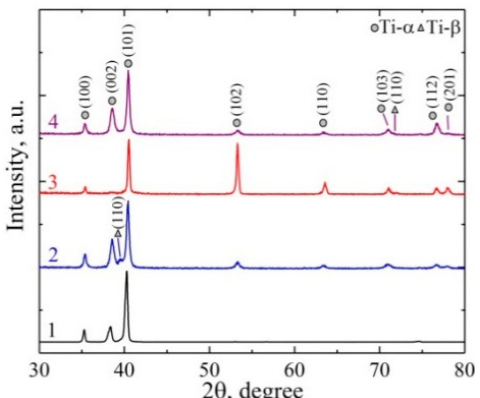
Figure 11. X-ray diffraction patterns of as-built (1—outermost surface layer, 2—core region) and Figure 11. X-ray di ff raction patterns of as-built (1—outermost surface layer, 2—core region) and irradiated Ti–6Al–4Vsample (3—molten surface layer, 4—heat affected zone). irradiated Ti–6Al–4Vsample (3—molten surface layer, 4—heat a ff ected